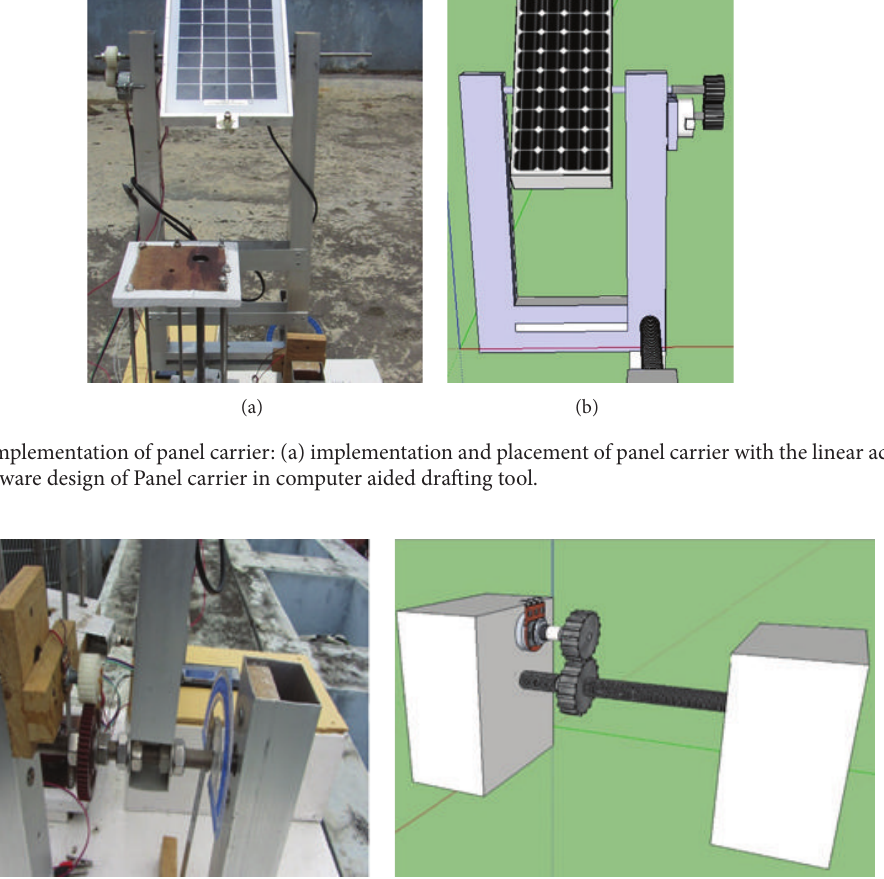
with a gear is placed on the body of the aluminium